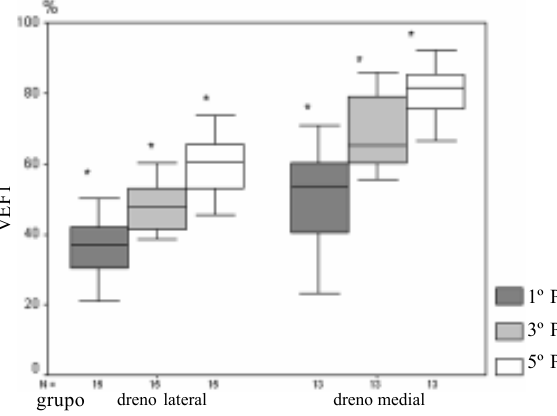
Fig. 3 - Distribuição representativa das alterações do VEF percentual nos 1º, 3º e 5º dias de PO em relação aos valores pré- operatórios, comparação entre os grupos com inserção do dreno pleural nas regiões lateral e medial, considerando como 100% o valor basal do pré-operatório. * p < 0,05